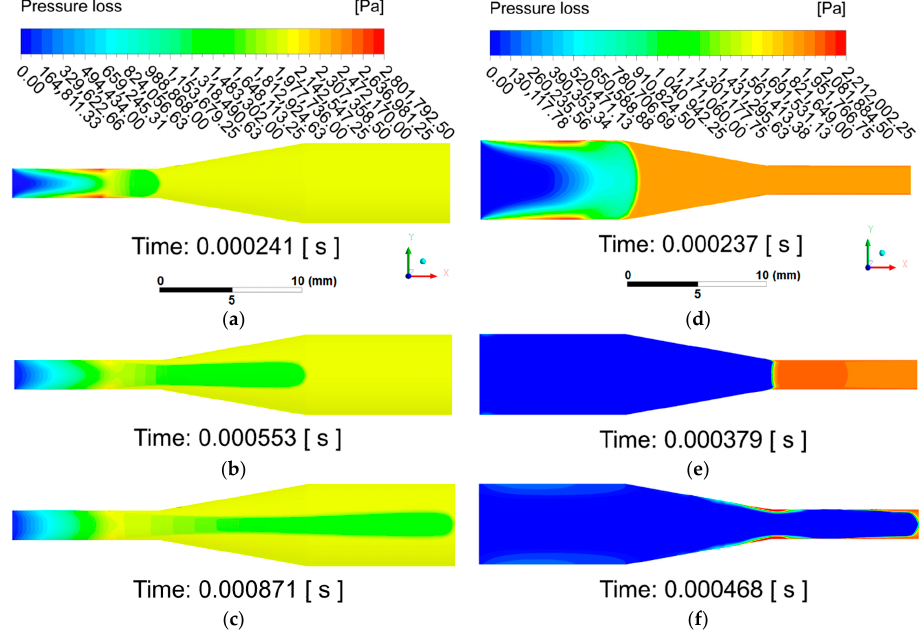
Figure 14. Pressure loss results of ( a ) diffuser case in the first selected timestep, ( b ) diffuser case in the second selected timestep, ( c ) diffuser case in the third selected timestep, ( d ) confusor case in the first selected timestep, ( e ) confusor case in the second selected timestep and ( f ) confusor case in the third selected